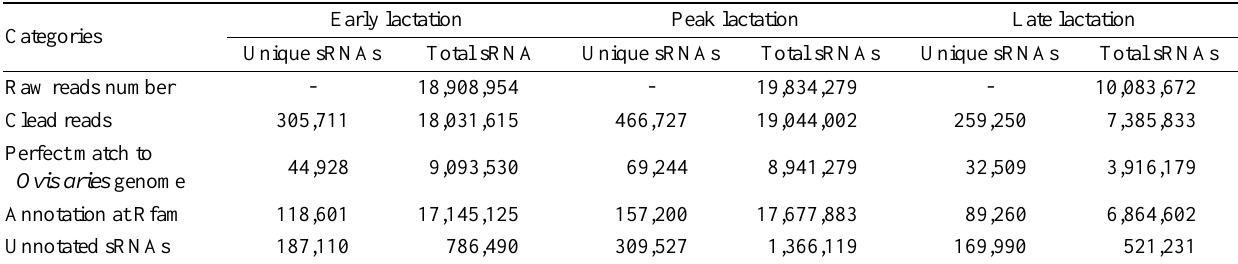
Early lactation